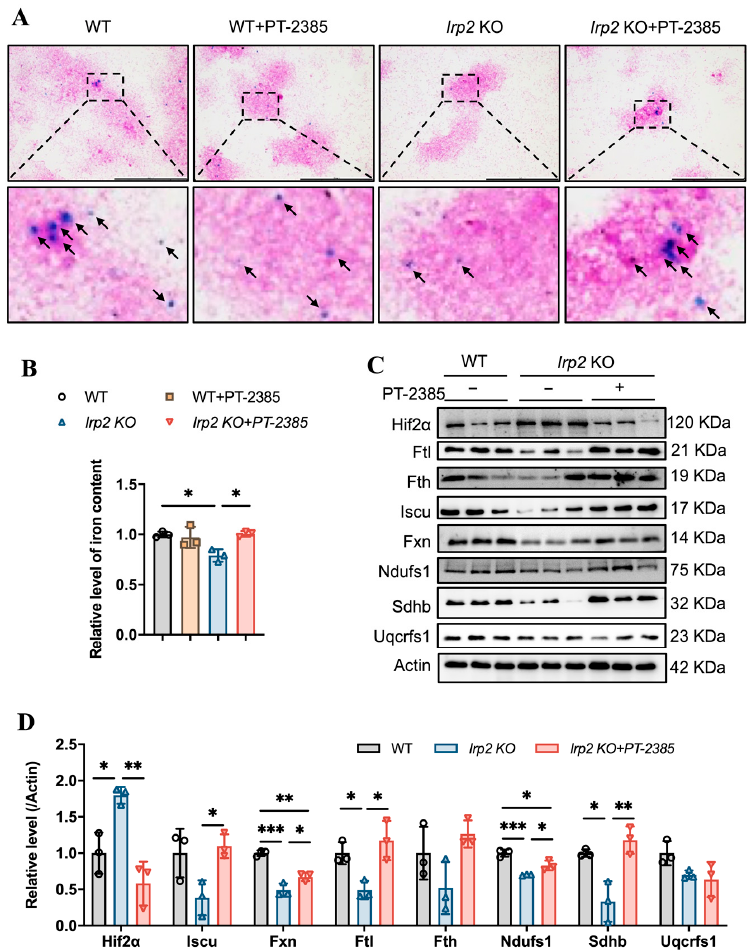
Figure 2. Hif2 inhibition increases available iron content and Fe-S cluster synthesis to maintain hematopoietic function in bone marrow. ( A ) Prussian blue staining of bone marrow smears. Arrows point to iron-stained positive areas. ( B ) Iron content in bone marrow determined by ferrozine assays. ( C ) Western blot analysis of expression of Hif2, iron-related proteins (Fth and Ftl), Fe-S cluster synthesis-related proteins (Fxn and Iscu), and respiratory chain-related proteins (Ndufs1, Sdhb, and Uqcrfs1) in bone marrow. Actin was used as an internal control. ( D ) Quantification of data in ( C ) to show significance; n = 3. Results are shown as mean ± SD. One-way ANOVA was used for significance. * p < 0.05, ** p < 0.01, *** p <